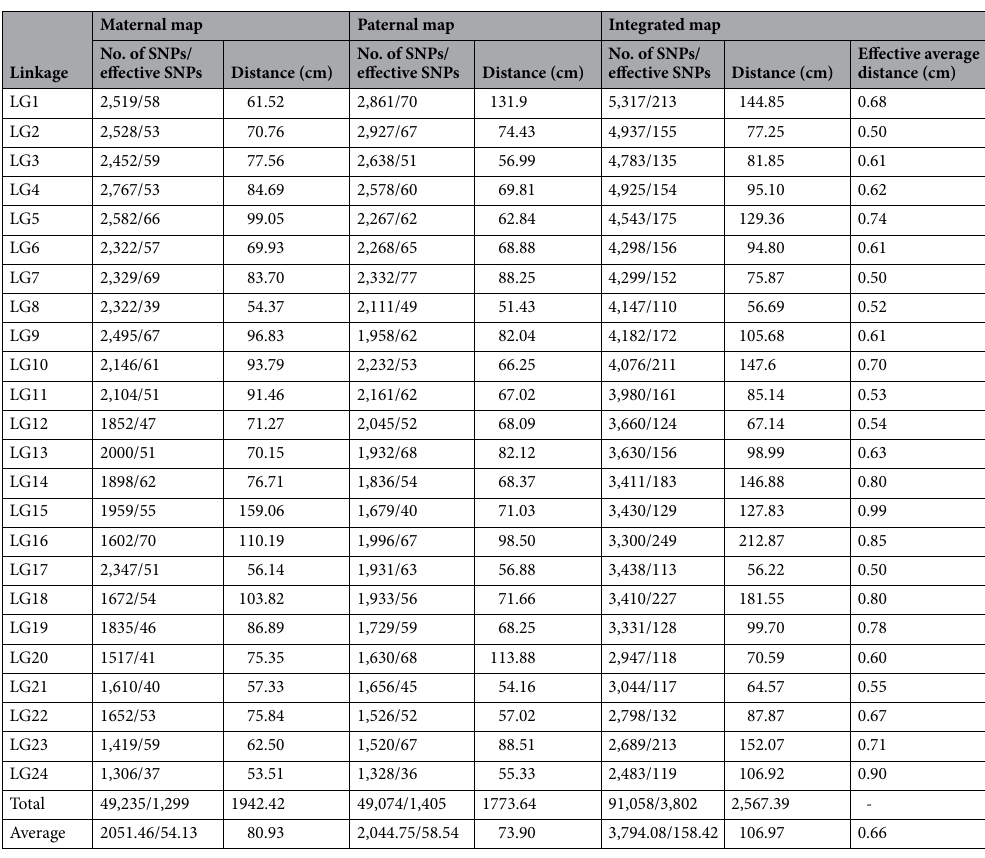
Table 3. Characteristics of genetic maps and anchoring scaffolds of L.